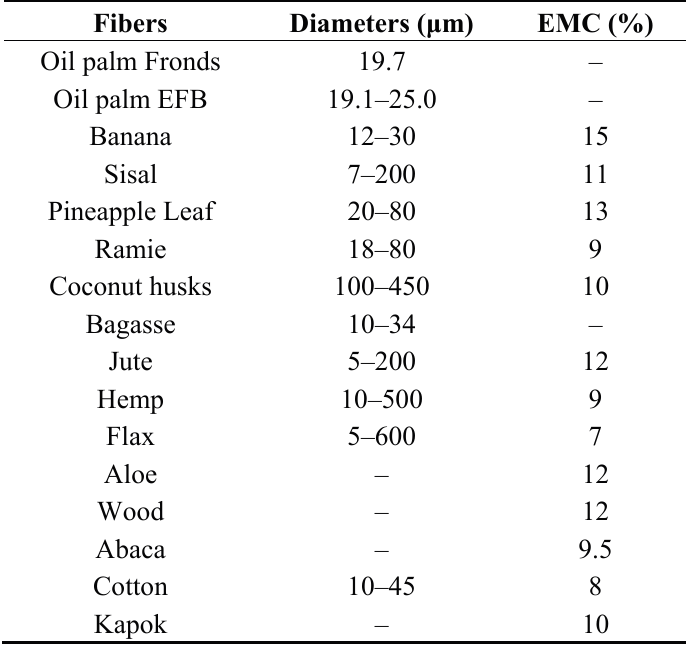
Table 3. Average diameter and equivalent moisture content (EMC) of natural fibers